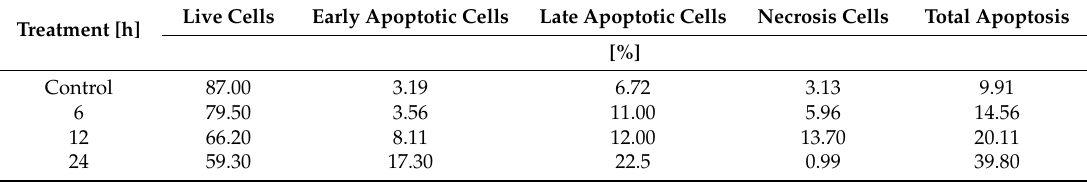
Table 4. Cells of SK-LU-1 response to treatment with fraction extract of A. lechuguilla . Treatment [h]